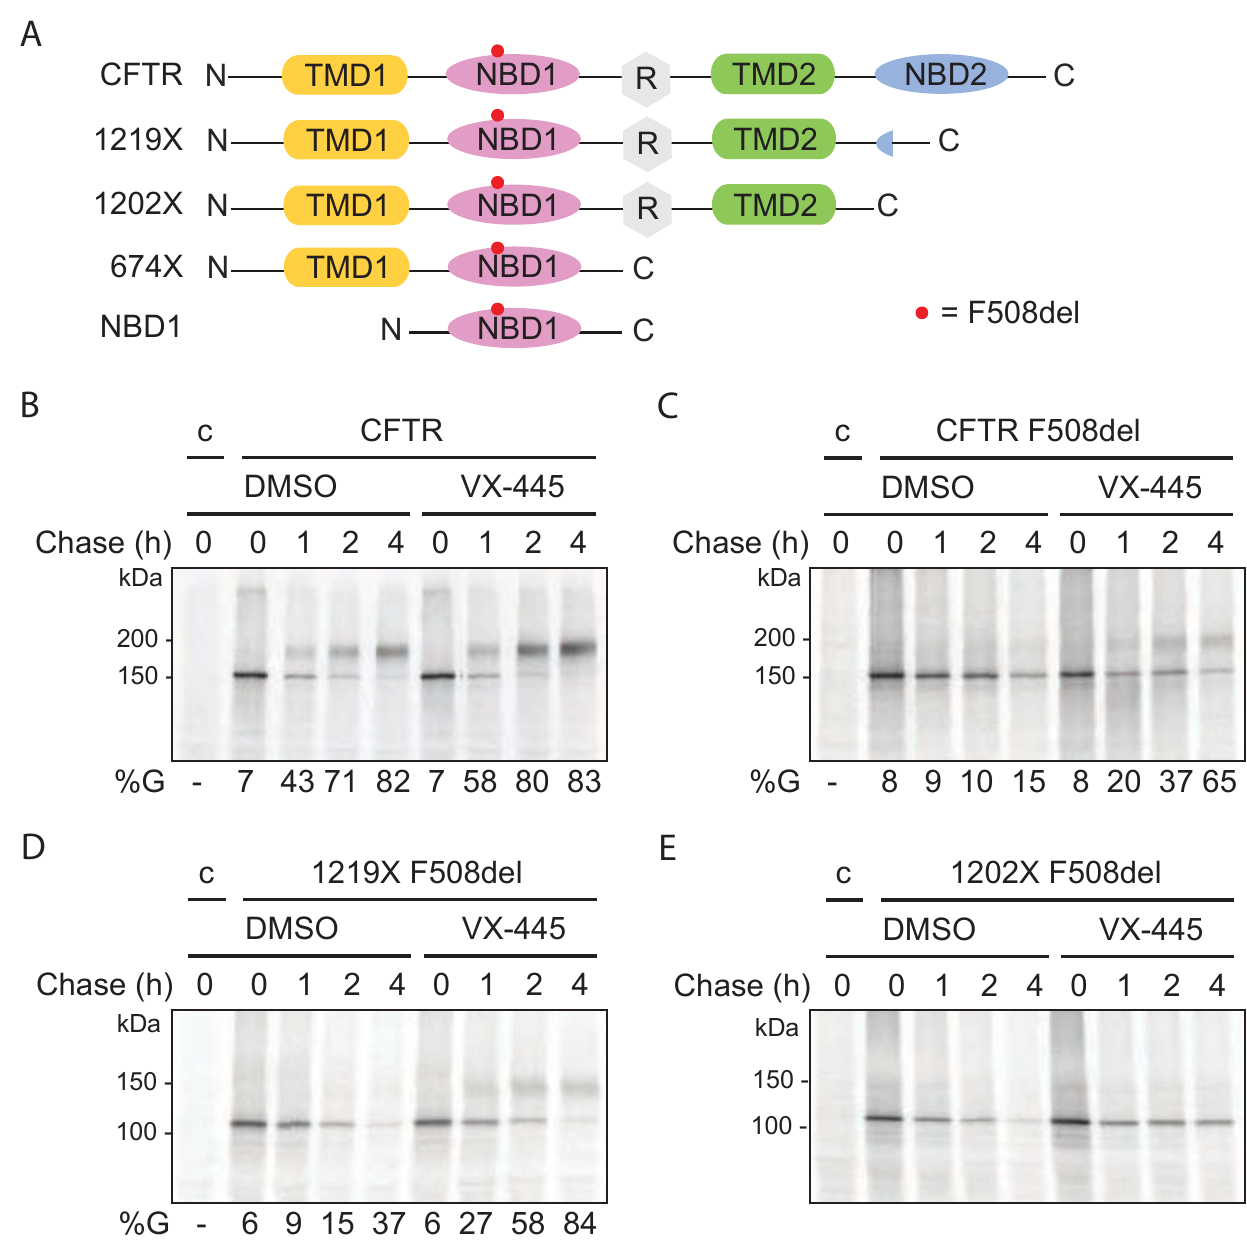
Figure 8. The action of VX-445 requires TMD1-NBD1-R-TMD2 ( A ) Schematic representation of constructs used in ( B – G ). ( B ) HEK293T cells expressing full-length CFTR was radiolabeled for 15 min and chased for 0, 1, 2, or 4 h. VX-445 (3 µ M) was added during starvation, pulse, and chase and